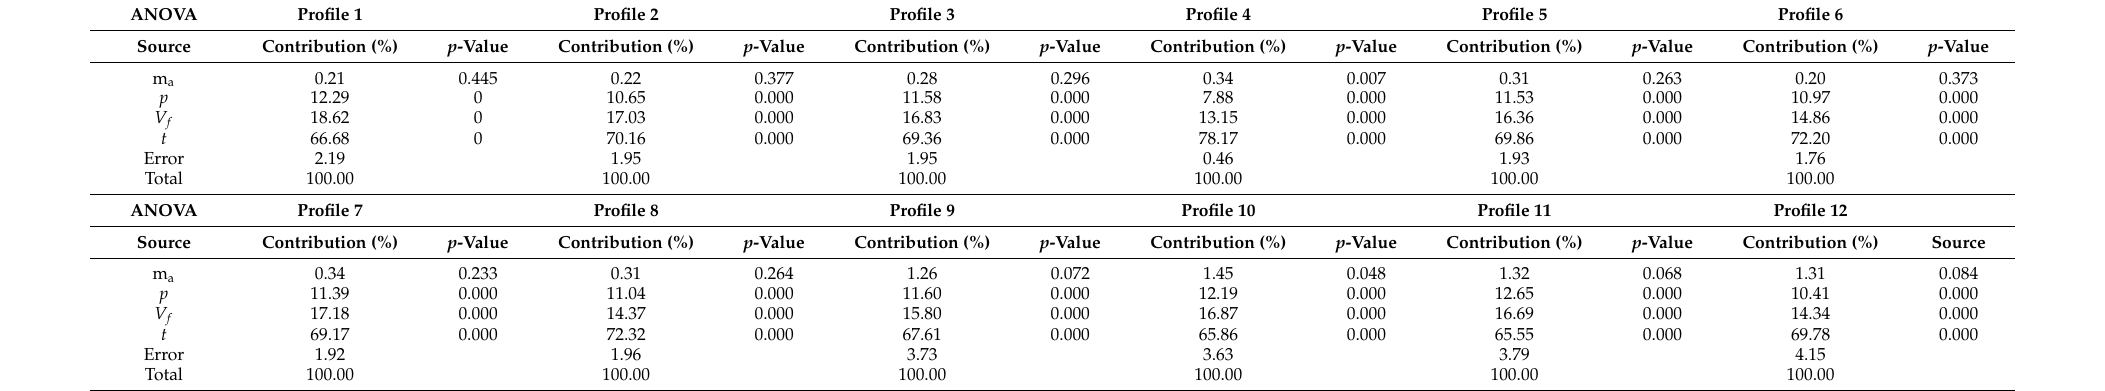
Table 8. Analysis of variance of material removal